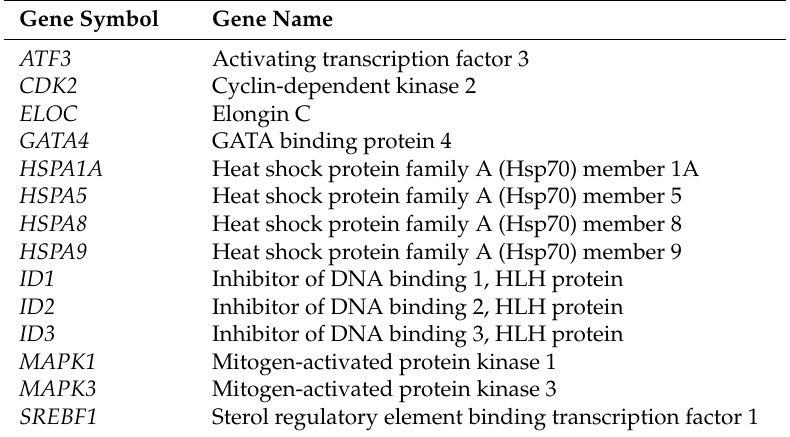
Table 1. The 14 overlapping, interacting EED–ID protein-depression genes.